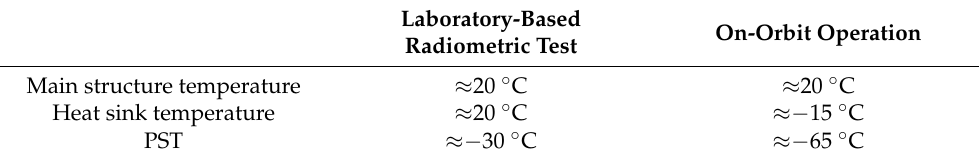
Figure 3. The SWIR detector assembly. Two SWIR detectors in the same band are mounted back to back on a heat sink. The SWIR detectors and cold shield are mounted on the heat sink and connected to the cry radiator through the heat pipe. Table 2. PSAC SWIR detector assembly temperature comparison under two operating environ ‐ ments.